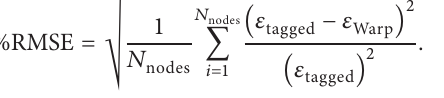
penalty 𝜓 𝑎 in (8) through 2/3 of the analysis (6.7 seconds) after which it was held constant until the end of the